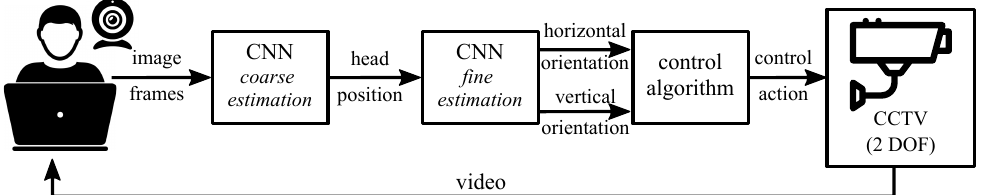
Figure 1. Simplified schematic of the proposed system. Image data captured by a webcam on the operator’s side of the system is evaluated in a coarse-to-fine manner via two independent neural network architectures. The head orientation in vertical and horizontal planes is used to calculate the corresponding control action fed to the CCTV camera